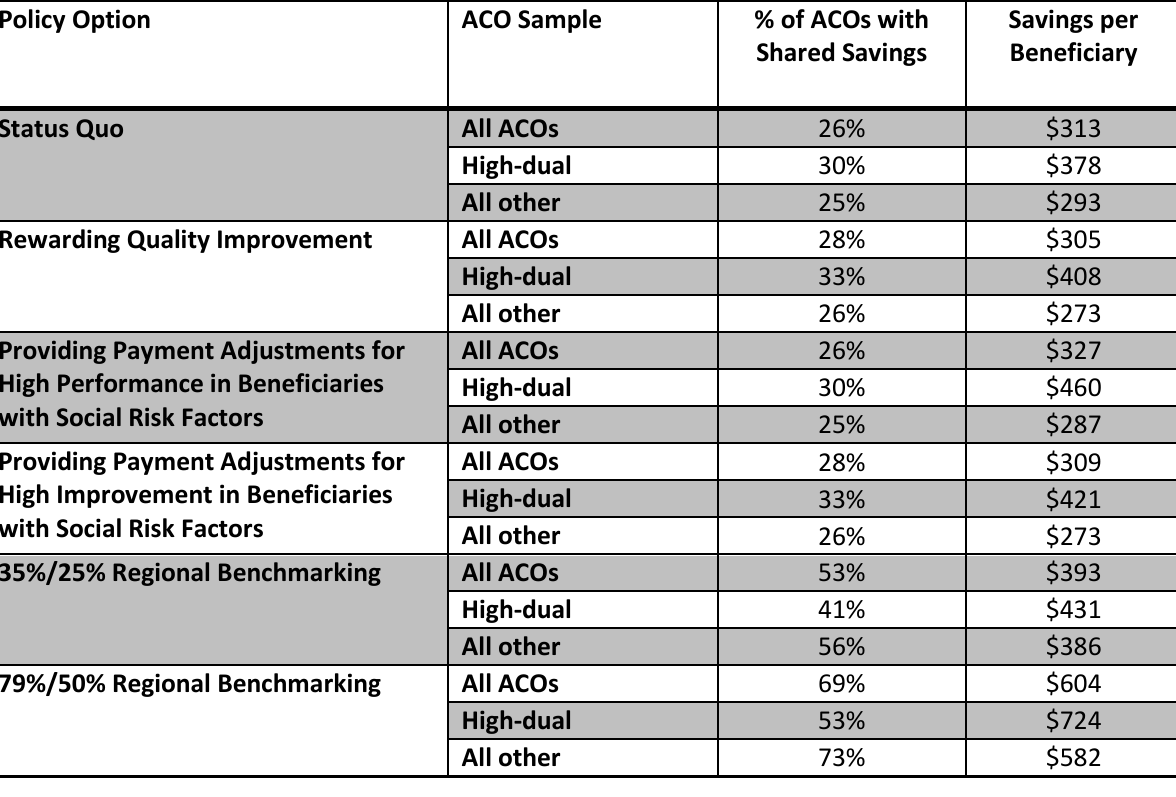
Table 9.17: Summary of Policy Simulations for Medicare Shared Savings Program Policy Option ACO Sample % of ACOs with